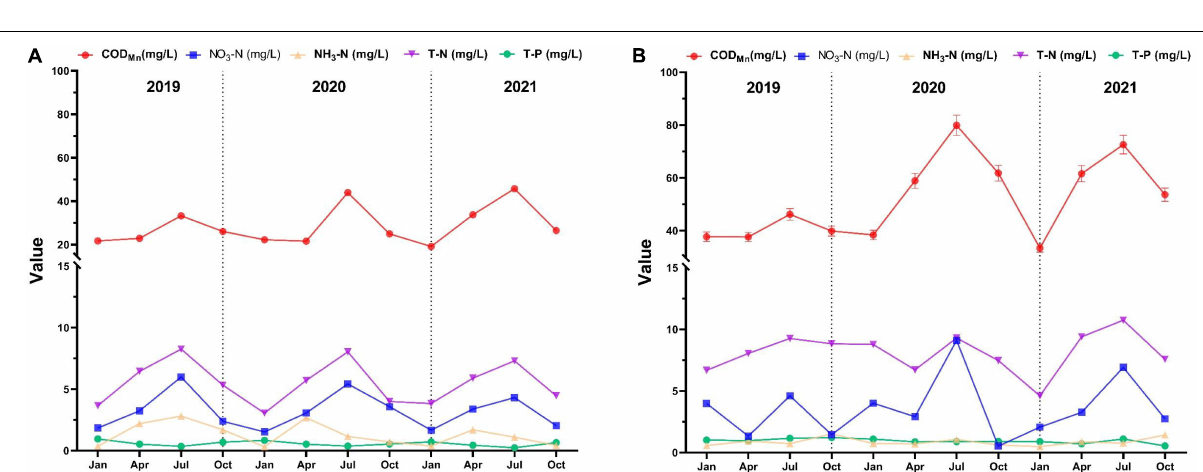
FIGURE 3 | Nutrient concentrations in water of South (A) and North (B) Taihu Lake.